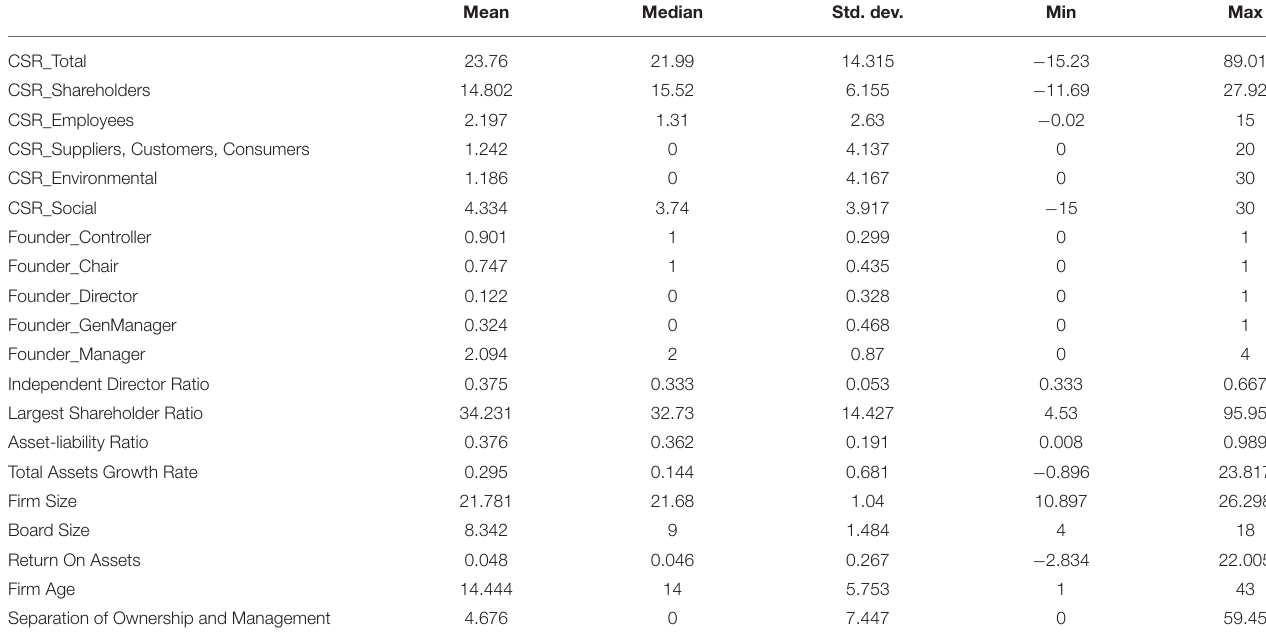
TABLE 4 | Descriptive statistics(Founder